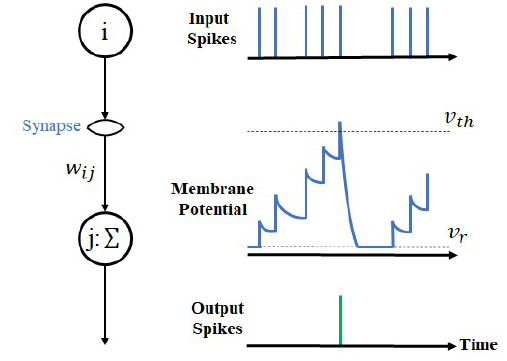
Figure 5. The dynamics of an LIF spiking